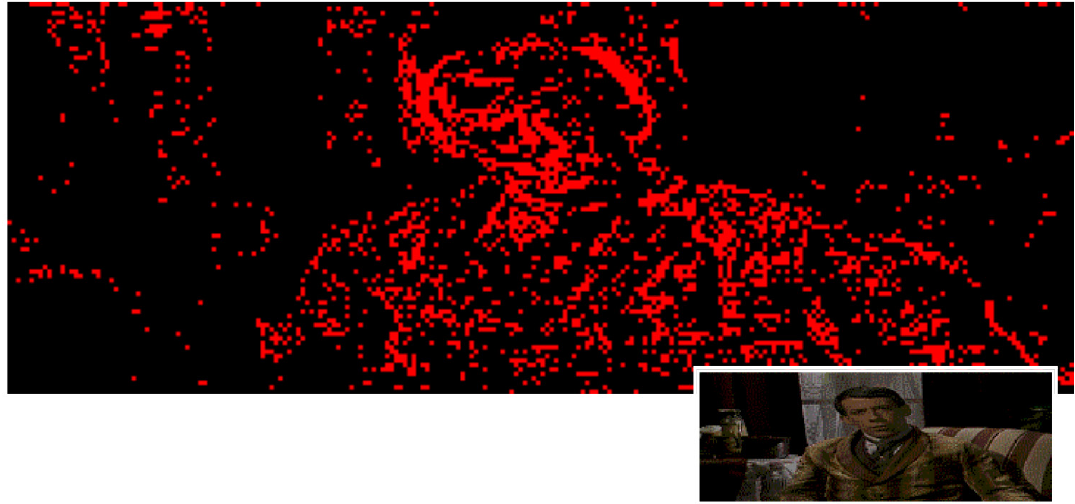
Figure 2. Plotting differences in pixel palette